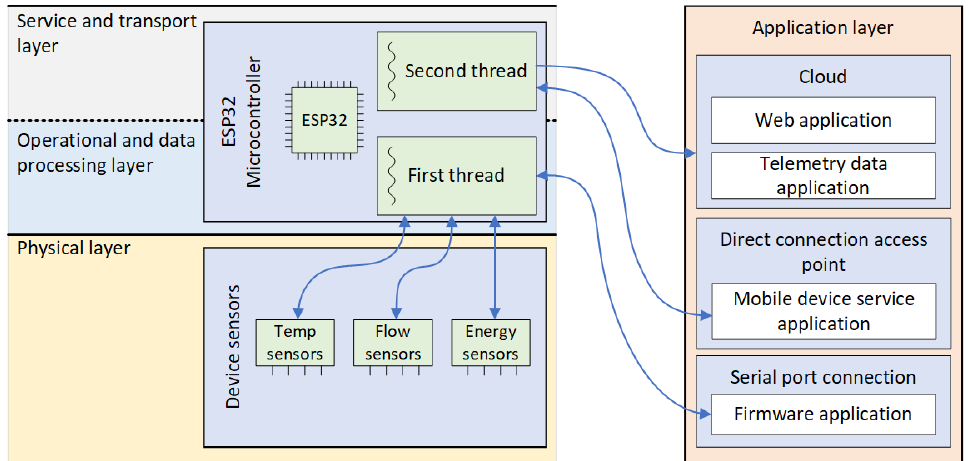
Figure 2. Proposed IoT architecture. The connection between the service and transport layer and the mobile device service application is achieved via direct connection access point. The connection be- tween the cloud and service transport layer can be achieved via WiFi connection and GSM